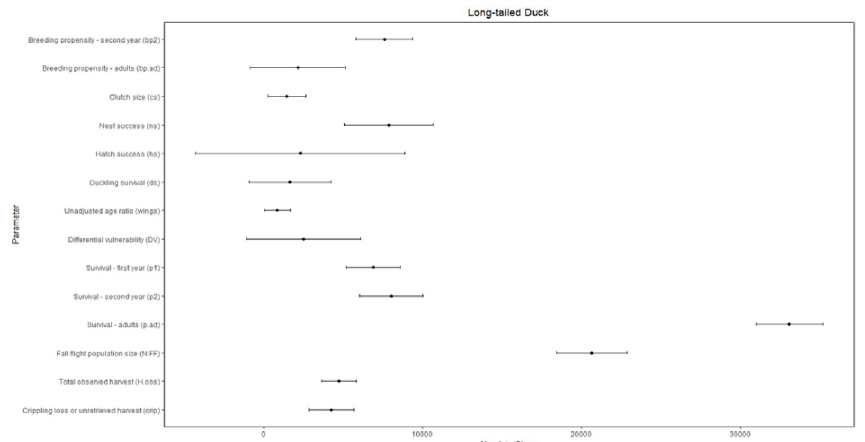
Fig 6. Sensitivity of the difference between allowable and observed harvest of long-tailed duck to individual demographic parameters as measured by the slope of linear relationships between the harvestdifference and standardized values of the demographic parameters, where greater absolute slope indicates higher sensitivity. Slope is affected by both the inherentsensitivity of growth rate and, hence, allowableharvest, to each parameter and its relative proportional uncertainty. Bars reflecting relative proportional uncertainty represent the coefficient of variationfor non-binomial parameters or concentration for binomial parameters and, in both cases, have been multipliedby 100 (dividedby 1000 for eiders) for scaling and presentation purposes.